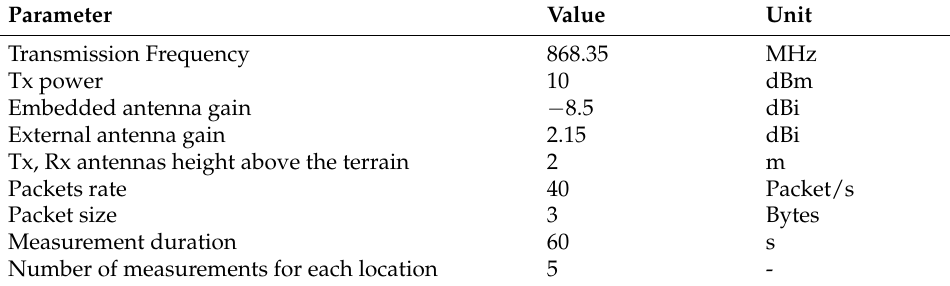
Table 2. Measurement setup